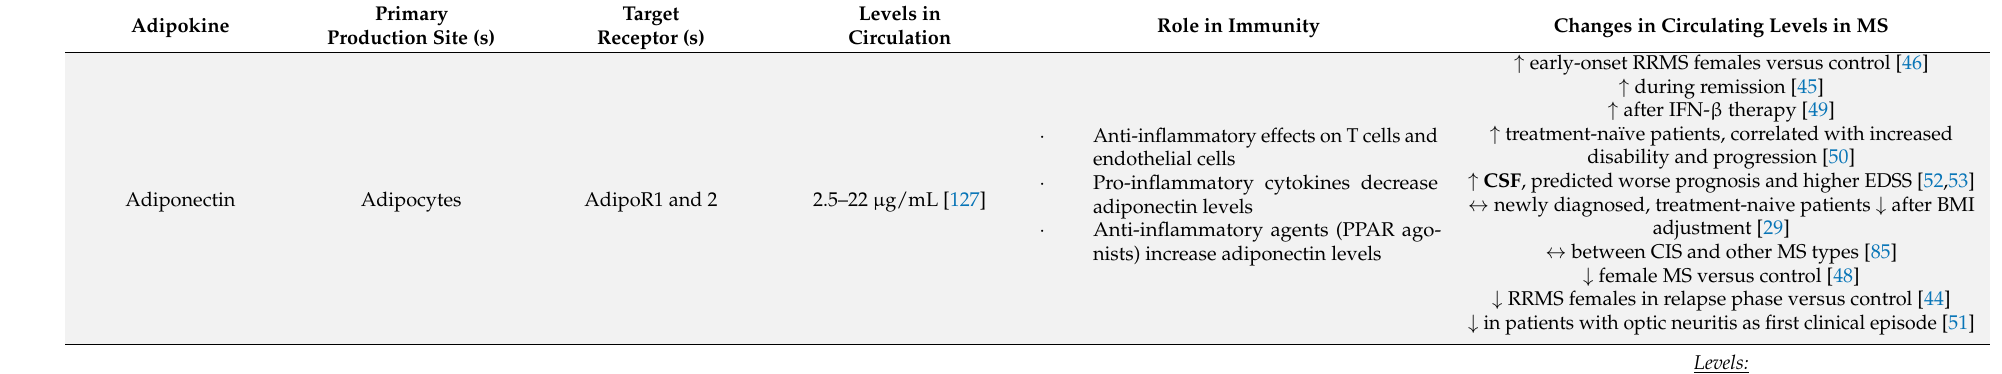
Table 1. Overview of adipokines, receptors, levels in circulation, role in immunity, and plasma and CSF levels in